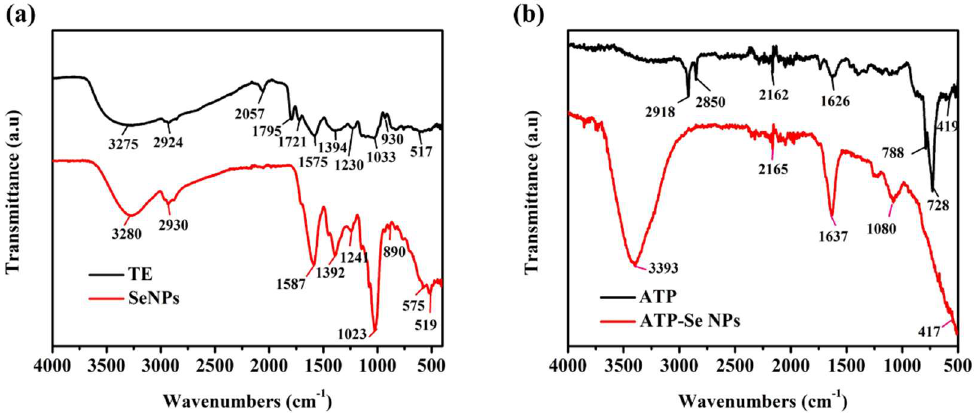
Figure 5. Fourier transform infrared spectroscopy (FTIR) analysis of Trichoderma sp extract (TE)- mediated SeNPs ( a ) and ATP-SeNPs ( b ).